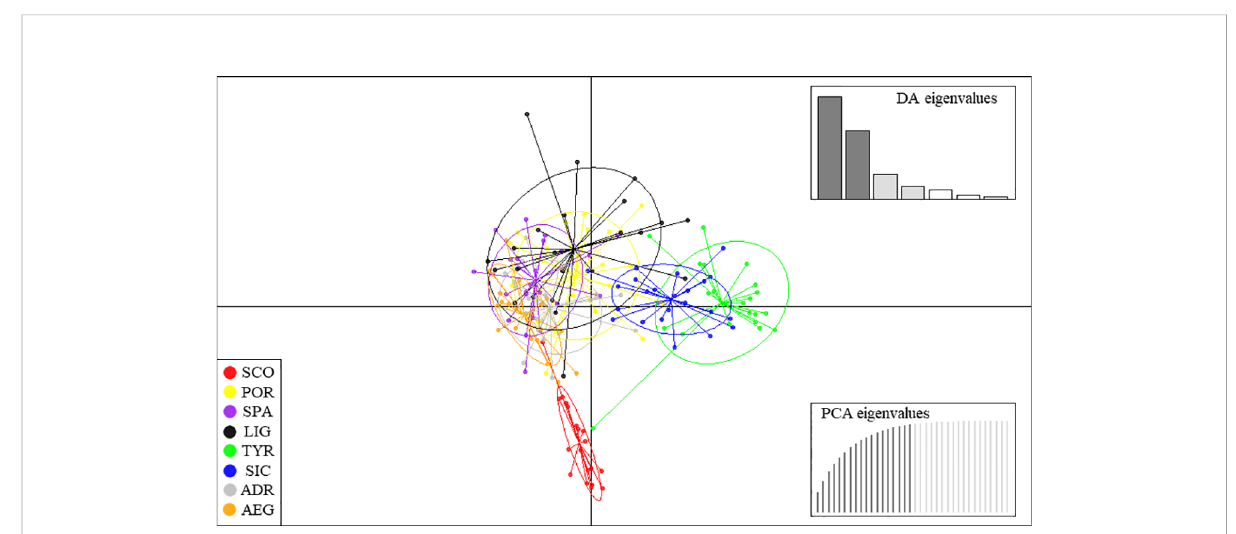
FIGURE 2 DAPC scatterplot of the Galeus melastomus samples. DAPC cluster ellipses were set to contain 95% of genotypes. Discriminant analysis (DA) eigenvalues and principal component analysis (PCA) eigenvalues were selected as displayed to avoid over fi tting. Sample acronyms are given as in Table